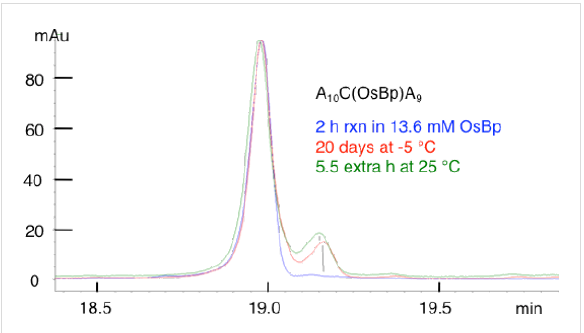
Figure 10: Overlapping CE profiles from stability studies of A 10 C(OsBp)A 9 in water: Blue, after 2 h reaction in 13.6 mM OsBp and purification by TrimGen to remove the excess OsBp. Red, solution stayed at − 5 °C for 20 days. Green, the same solution (red trace) left for 5.5 additional hours at 25 °C and analyzed to show more degrada- tion. The degradation peak exhibits the same mt as A 10 U(OsBp)A 9 , as shown by spiking the corresponding oligo, but a comparable mt does not constitute identification